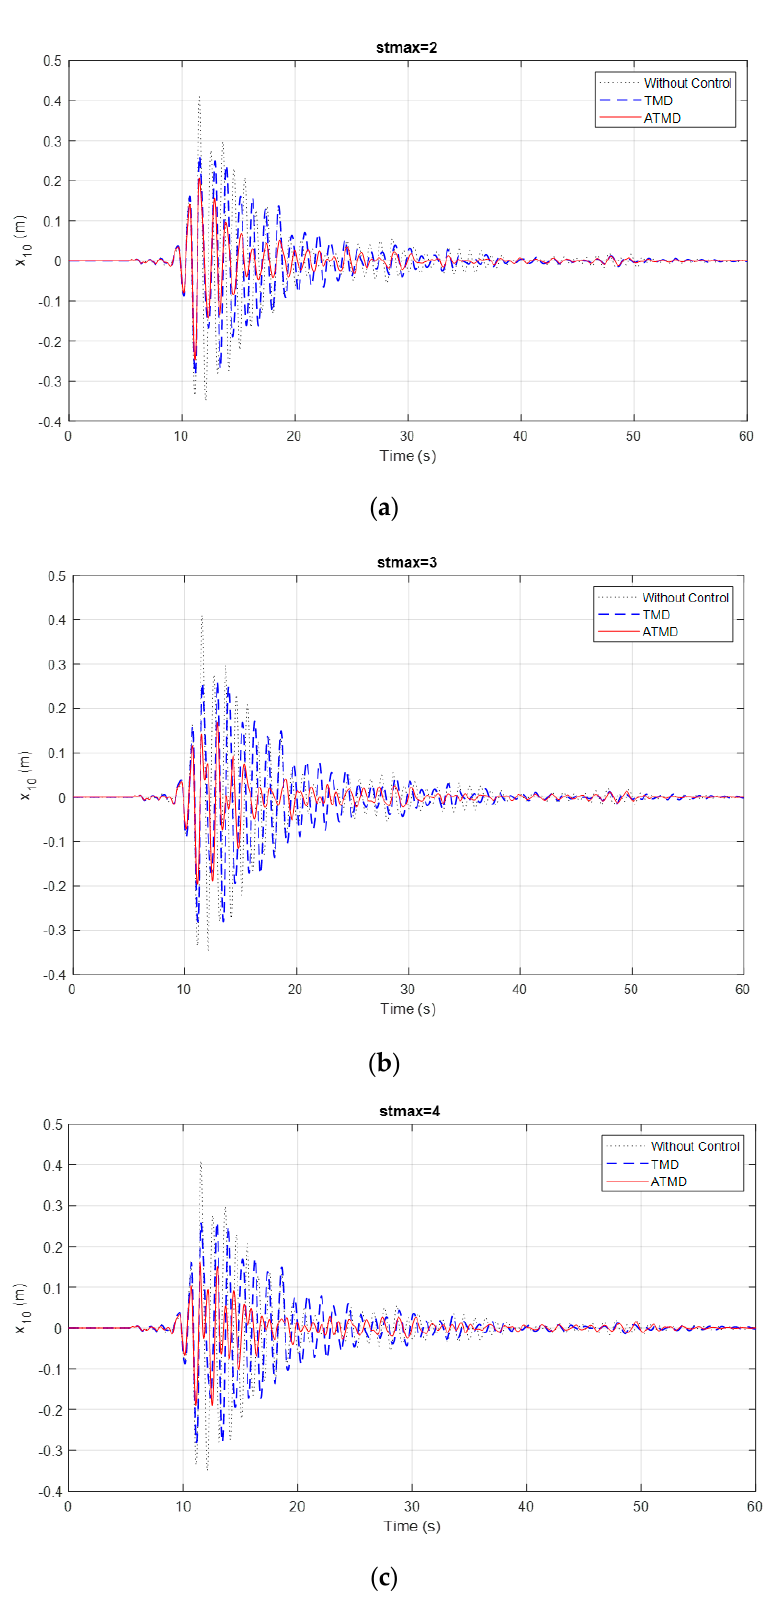
Figure 5. Time history displacement of the top story of the structure under the critical record. ( a ) st_max = 2; ( b ) st_max = 3; ( c ) st_max =